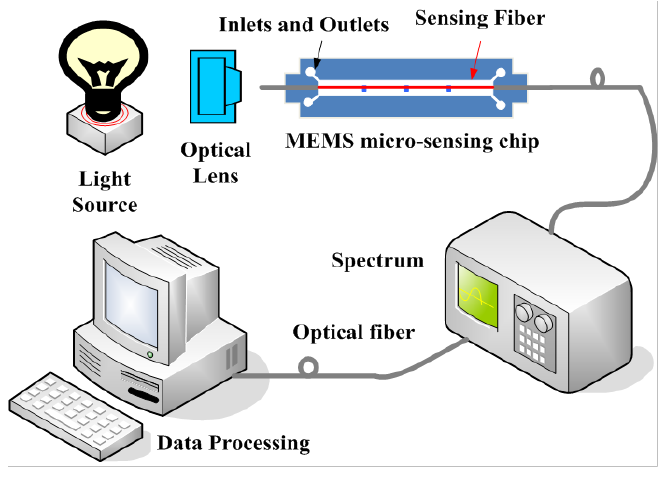
Figure 6. Schematic representation of the experimental